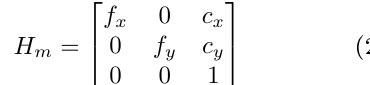
Fig. 7: Illustration of VNect network